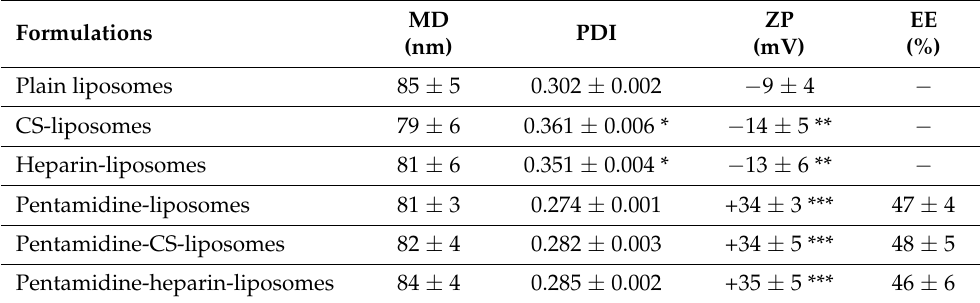
Table 2. Mean diameter (MD), polydispersity index (PDI), zeta potential (ZP), and pentamidine encapsulation efficiency (EE) of liposomes. Mean values ± standard deviations are reported ( n =